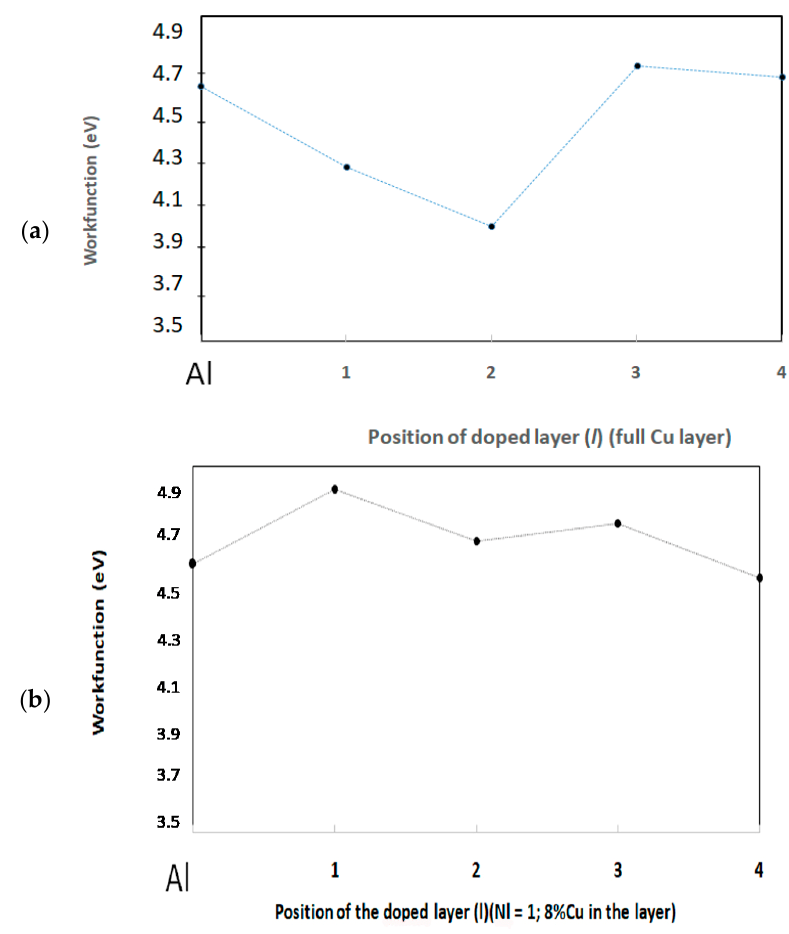
Figure 5. Workfunction (eV) of the alloys ( a ) for a complete monolayer of copper; ( b ) for Nl = 1 Cu atom in the layer, a concentration of 8% Cu in the layer, infinite dilution limit, as a function of the position of the doped layer. Position i corresponds to the layer l = i ( i = 1 to 4).The position “Al” corresponds to pure aluminum.